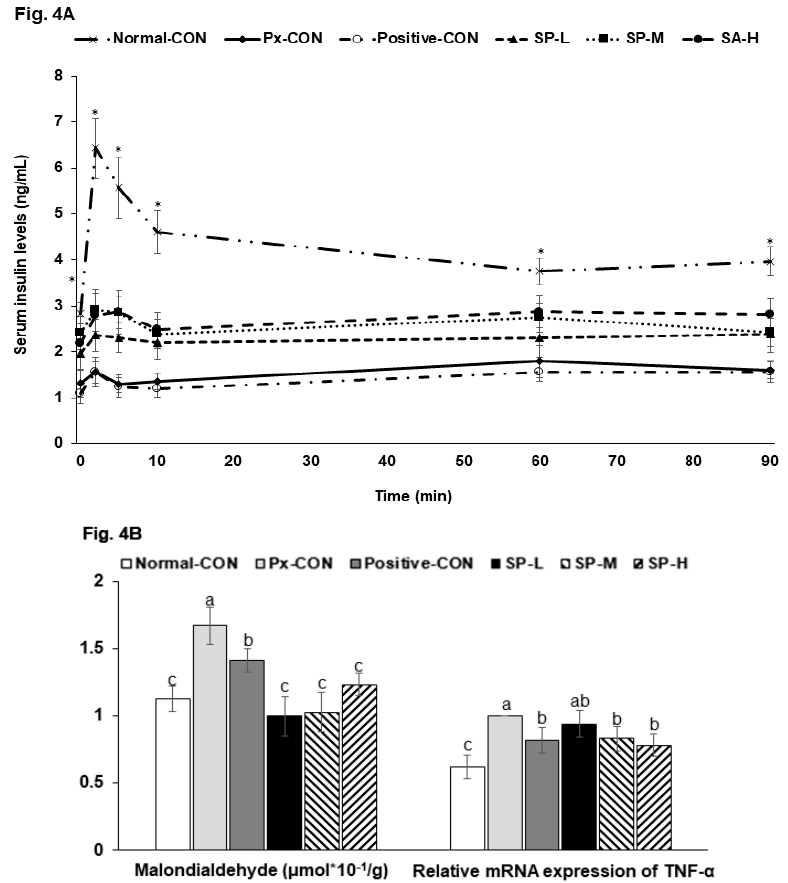
Figure 4. Changes in serum insulin concentrations during hyperglycemic clamp test and malondialdehyde contents and TNF- α mRNA expression in islets. ( A ). Changes of serum insulin concentration during hyperglycemic clamp procedure. ( B ). Malondialdehyde contents and TNF- α mRNA expression in islets. Serum insulin concentrations were determined after glucose infusion to achieve a serum glucose concentration of 100 mg/dL above baseline. Dots and error bars represent means ± SDs ( n = 10). a,b,c Different letters on bars indicate significant differences ( p < 0.05). * indicates a significant intergroup difference ( p < 0.05).